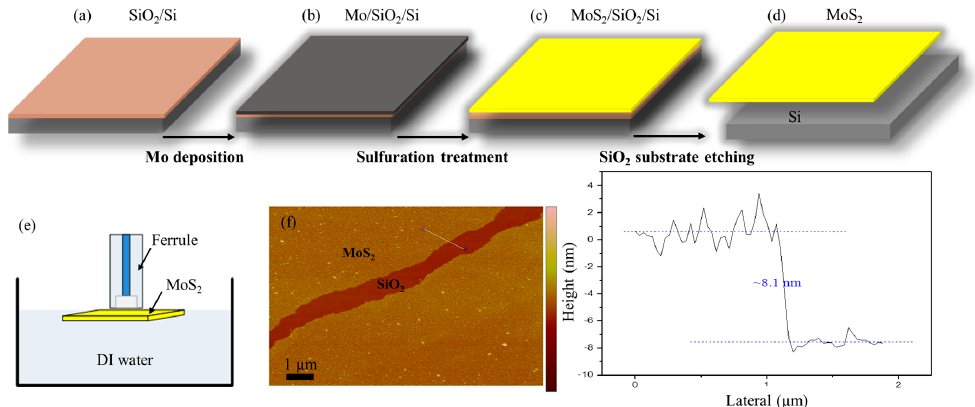
Figure 2. Fabrication process of the F ‐ P cavity with a MoS 2 membrane. ( a ) SiO 2 /Si substrate. ( b ) Depositing Mo film onto the SiO 2 /Si substrate. ( c ) Treating the Mo/SiO 2 /Si assembly with sulfurization. ( d ) Separating MoS 2 membrane from the MoS 2 /SiO 2 /Si assembly. ( e ) MoS 2 membrane ‐ covered fiber ‐ capillary tip. ( f ) Thickness measurement of MoS 2 membrane by atomic force microscopy (AFM).